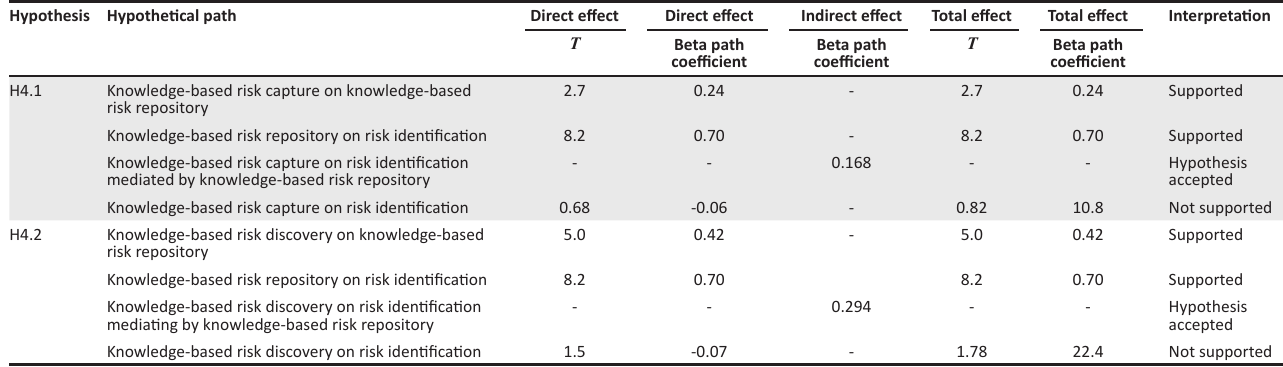
TABLE 7: Test results for H4.1 and H4.2. Hypothesis Hypothetical